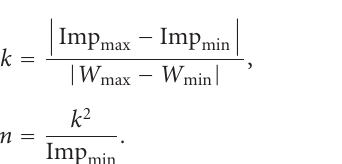
Figure 6: Percentage of improvement in corretly delivered I-, P-, and B- packets against